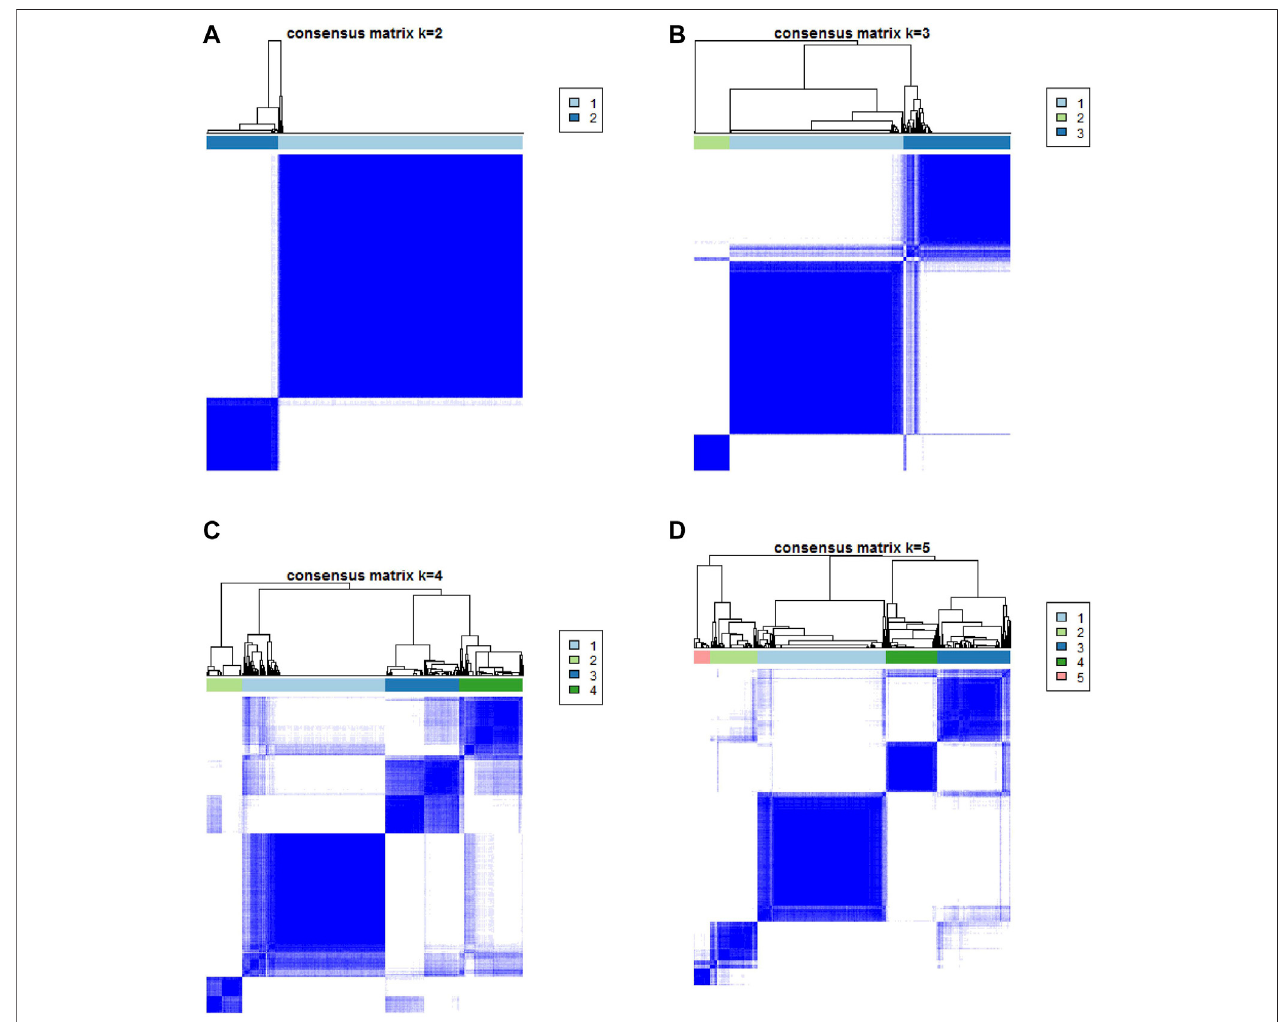
FIGURE4| BasedonDEGs,consensusmatrixesofallBLCAsamples. (A – D) InconsensusmatrixesofallBLCAsamplesforeachk(k=2 – 5),theconsensusmatrix was the crispest when K = 2.